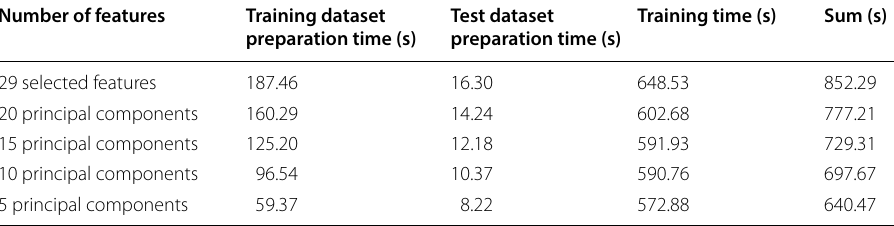
Table 4 Relationship between the number of principal components and training efficiency Number of